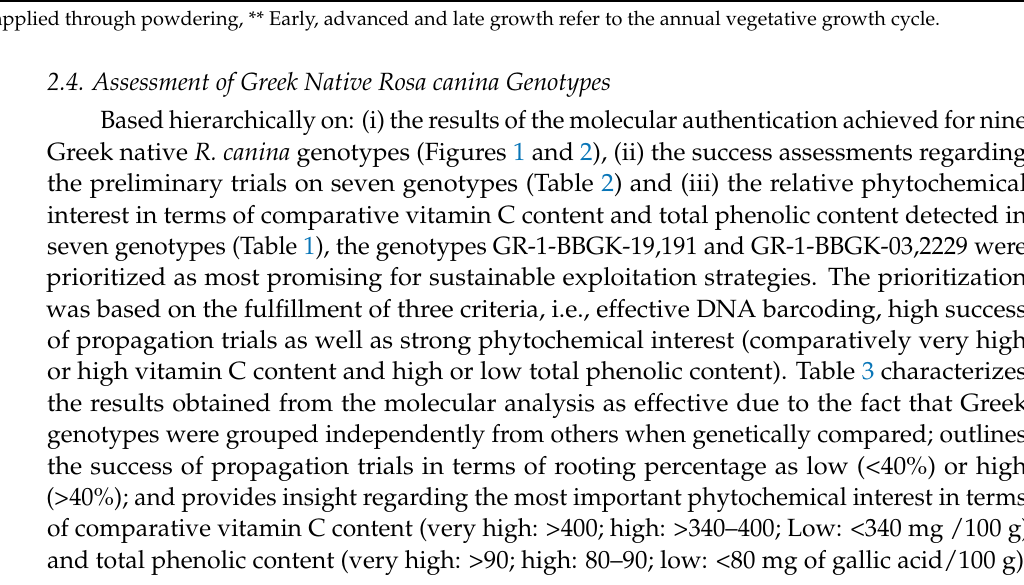
Table 3. Multifaceted assessment of Greek native Rosa canina genotypes based on molecular authenti- cation achieved, (Figure 1), success of preliminary propagation trials (see Table 2 for details), and relative phytochemical interest in terms of comparative vitamin C content (very high: >400 mg/100 g; high: >340–400; Low: <340) and total phenolic content (very high: >90 of gallic acid/100 g; high: 80–90; low: <80